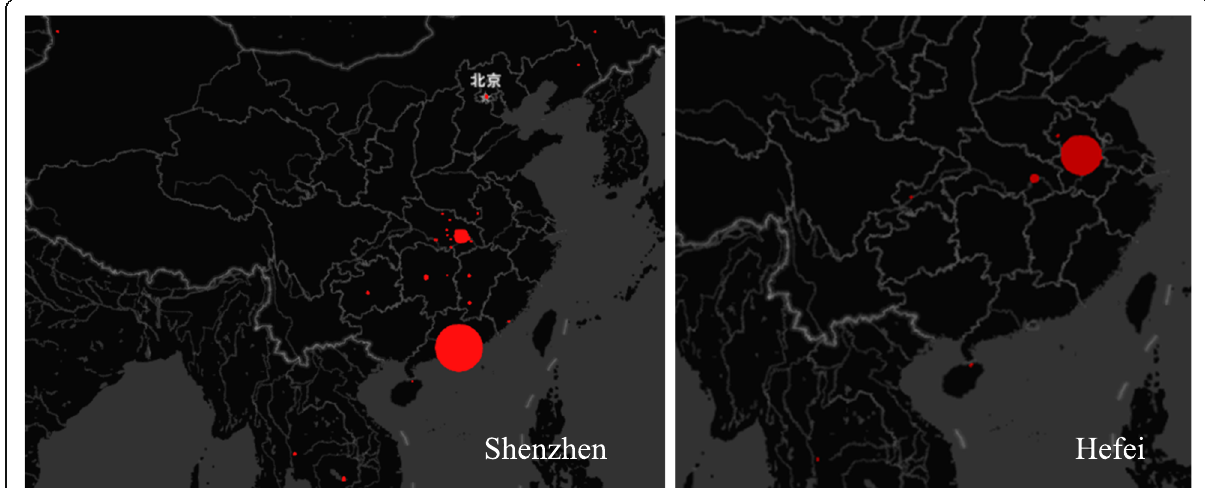
Fig. 5 Geographic distribution of symptom onset